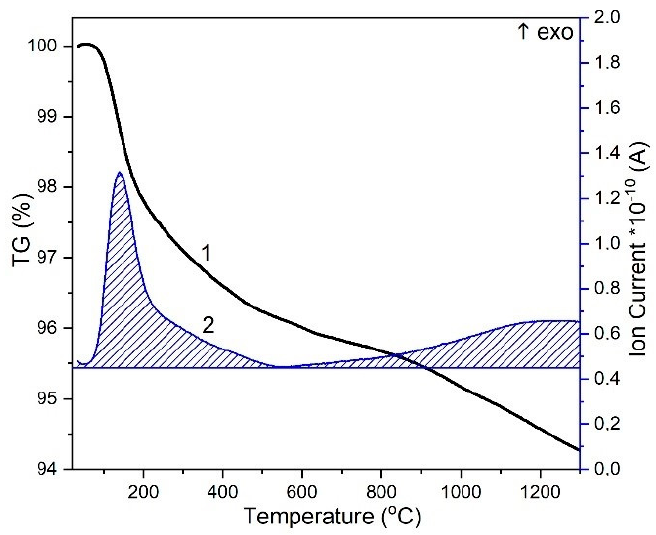
Figure 2. Simultaneous thermal analysis of the HA powder: 1—weight loss; 2—evolved water. Table 3. Phase composition and structural parameters of the stoichiometric HA sample after sintering in the high- temperature furnace at different temperatures and at a heating rate of 5 ◦ /min. Temperature ( ◦